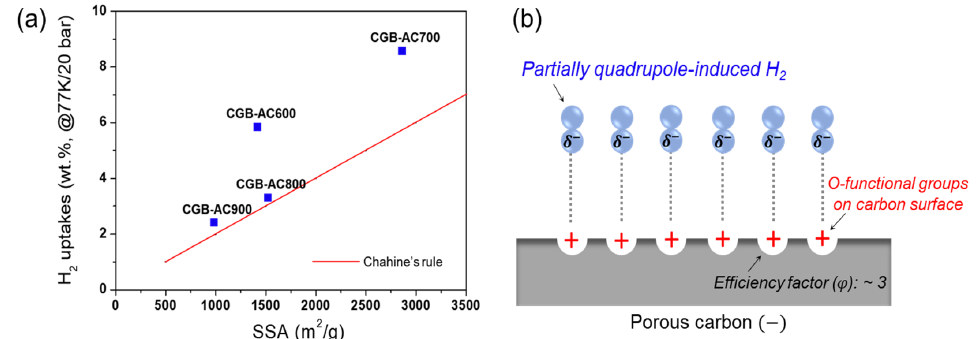
Figure 4. ( a ) Relationship between H 2 uptake capacity and specific surface area for CGB-AC samples and ( b ) schematic illustration of the oxygen-rich porous carbon surface of CGB-AC and the adsorption mechanism of partially quadrupole-induced H 2 molecules.